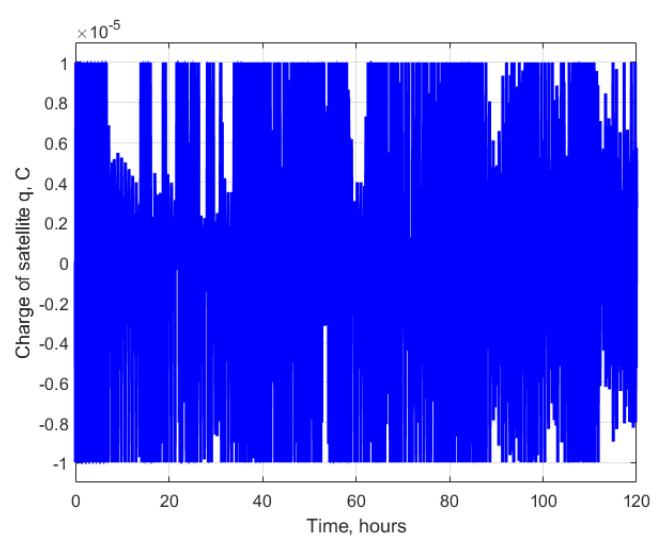
Figure 9. Satellite charge.